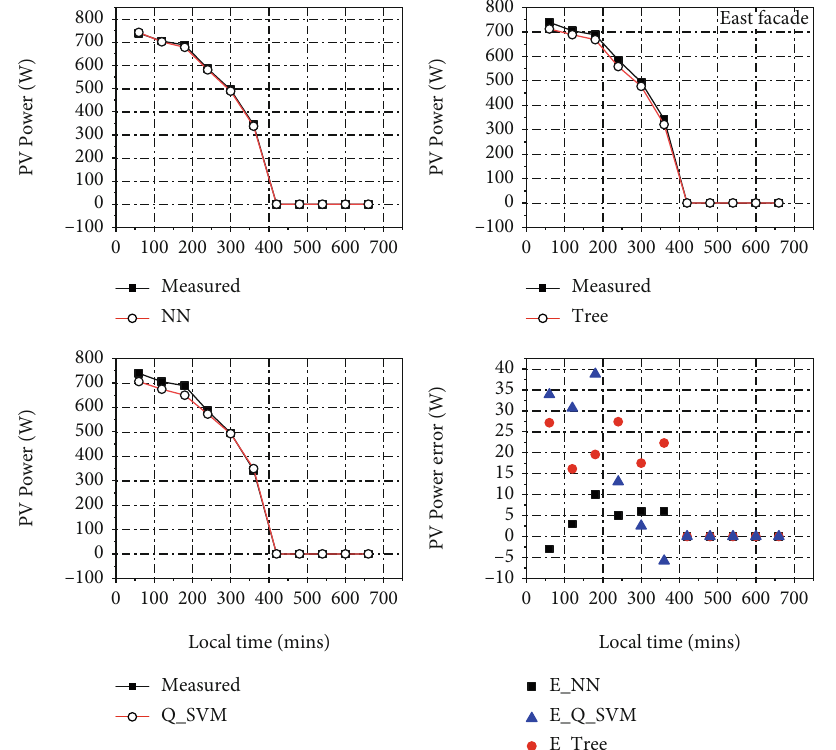
Figure 9: PV power prediction and error of the NN-QSVM-Tree models for the east